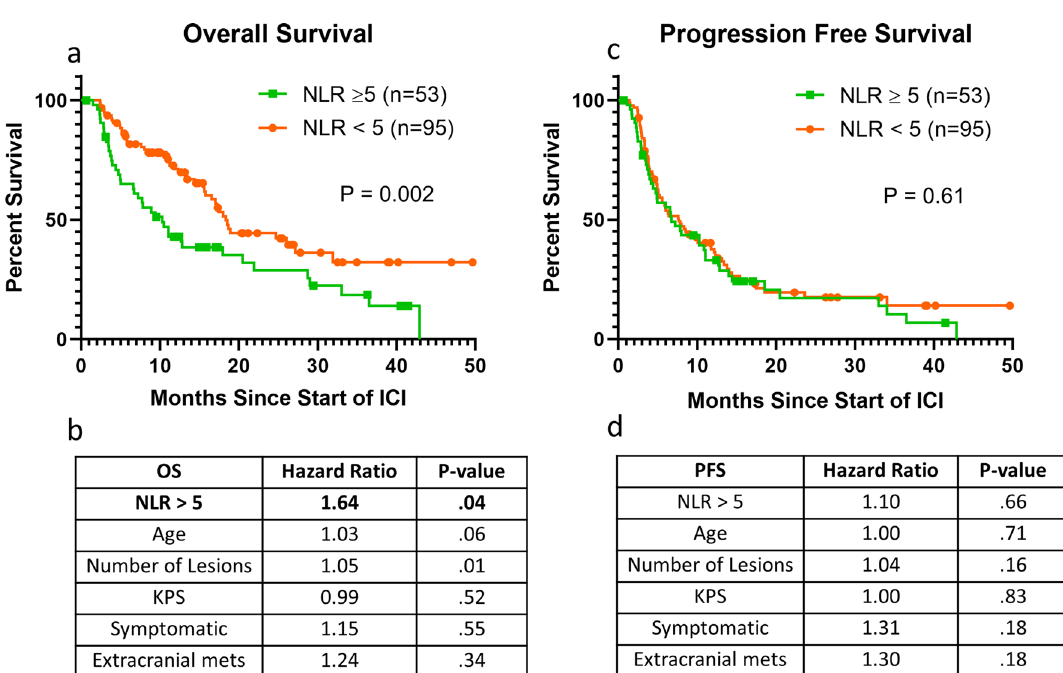
Figure 2. NLR is associated with overall survival after start of ICI but not associated with PFS. ( a ) Overall Survival differences between those with NLR ≥ 5 versus < 5. ( b ) Multivariable analysis of overall survival. ( c ) Progression-free survival differences between those with NLR ≥ 5 versus < 5. ( d ) Multivariable analysis of progression-free survival. ( a ) and ( c ) group differences tested with the Wilcoxon test. ( b ) and ( d ) estimates from Cox proportional hazards models and the associations tested with effect likelihood ratio